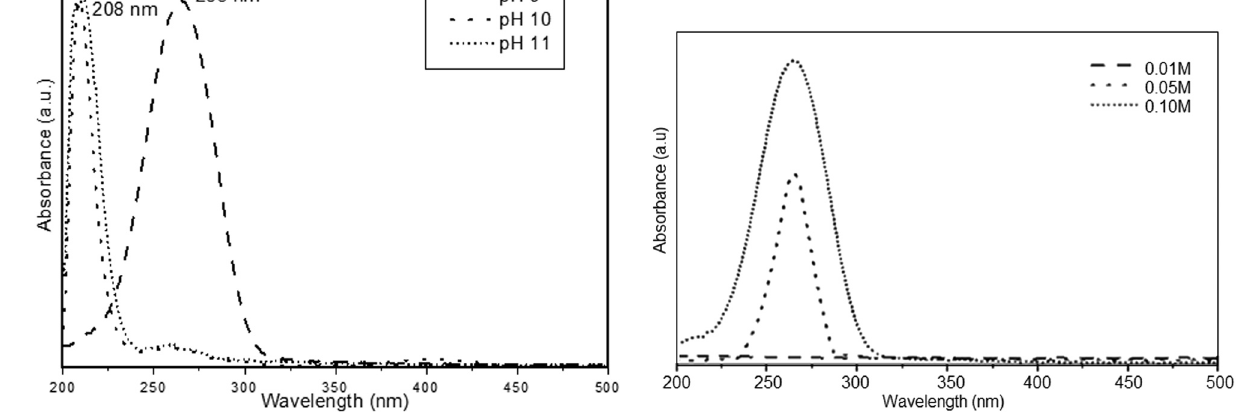
Figure 3: UV - Vis spectra of NiNPs at pH 9, 10, and 11. Figure 4: UV - Vis spectra of NiNPs at 0.01, 0.05, and 0.1